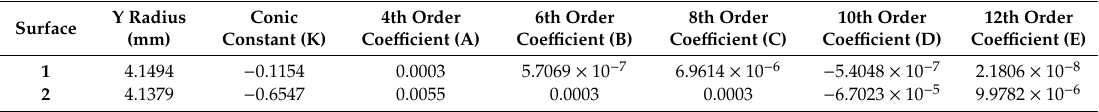
Table 6. Detailed parameters of aspherical surfaces for the virtual image.